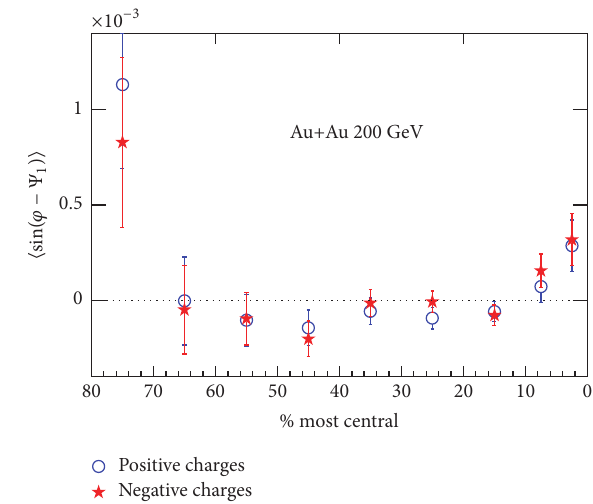
Figure 4: ⟨ sin (𝜑 − Ψ 1 )⟩ for positive and negative charges versus centrality for Au+Au collisions at √ 𝑠 NN = 200 GeV [45].